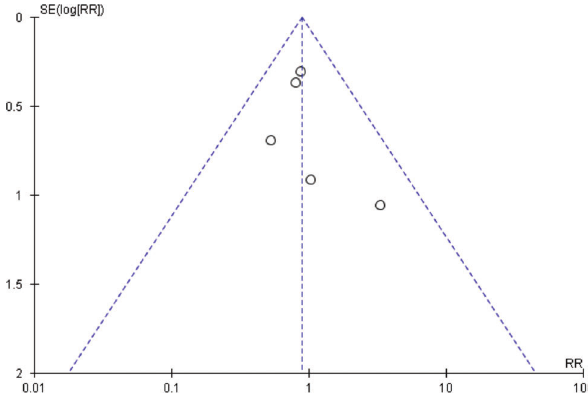
Figure 4 - Funnel plot of all complications in retrospective studies. All studies are inside the funnel plot.